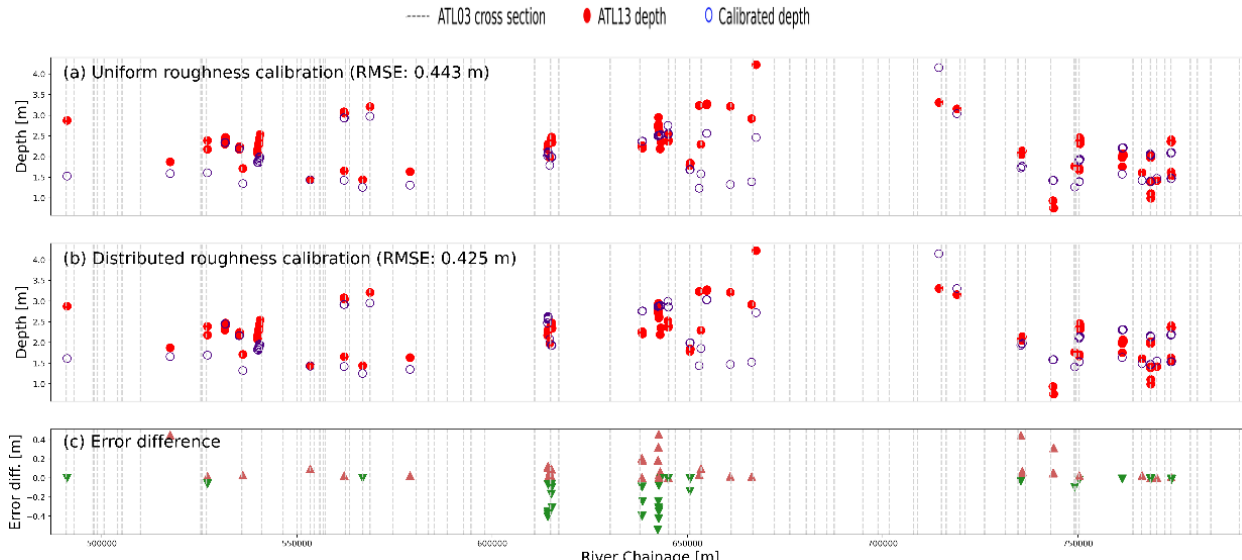
Figure A4. Validation data error for uniform depth calibration (a) , distributed roughness calibration for 16 Manning’s roughness (b) , and error difference between the uniform calibration and the distributed calibration (c)